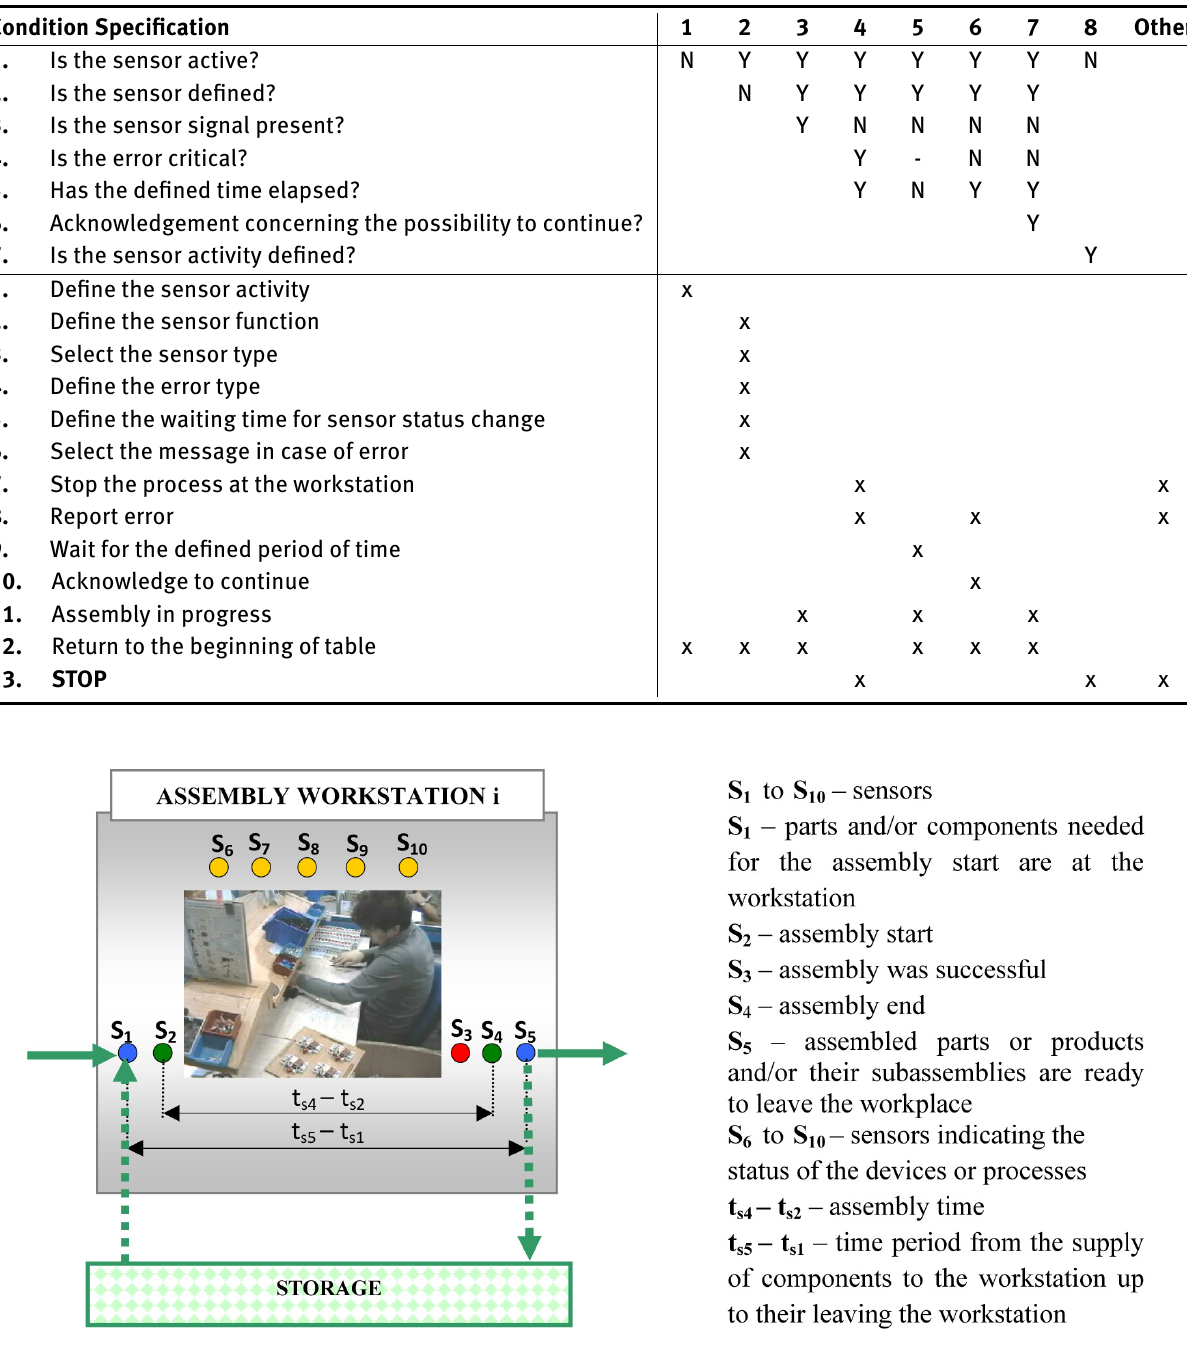
Table 1: Example of a decision table for the analysis of sensors definition and functioning.